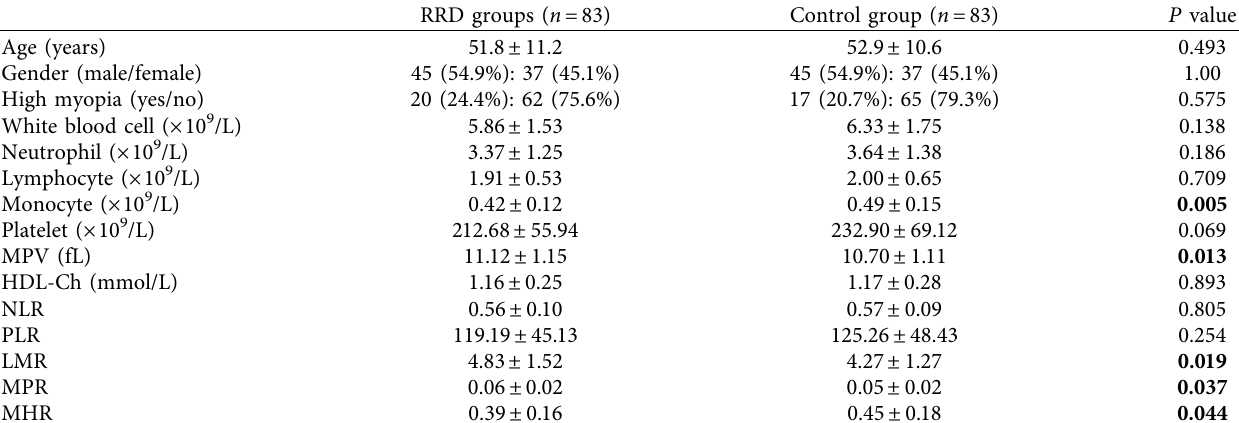
Table 1: Clinical features and laboratory parameters of included patients.